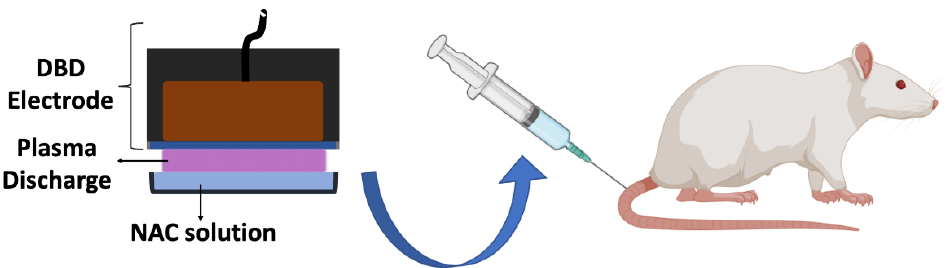
Figure 1. Experimental setup for treatment of NAC solution. After plasma treatment, NAC solution was injected into rats via tail vein.